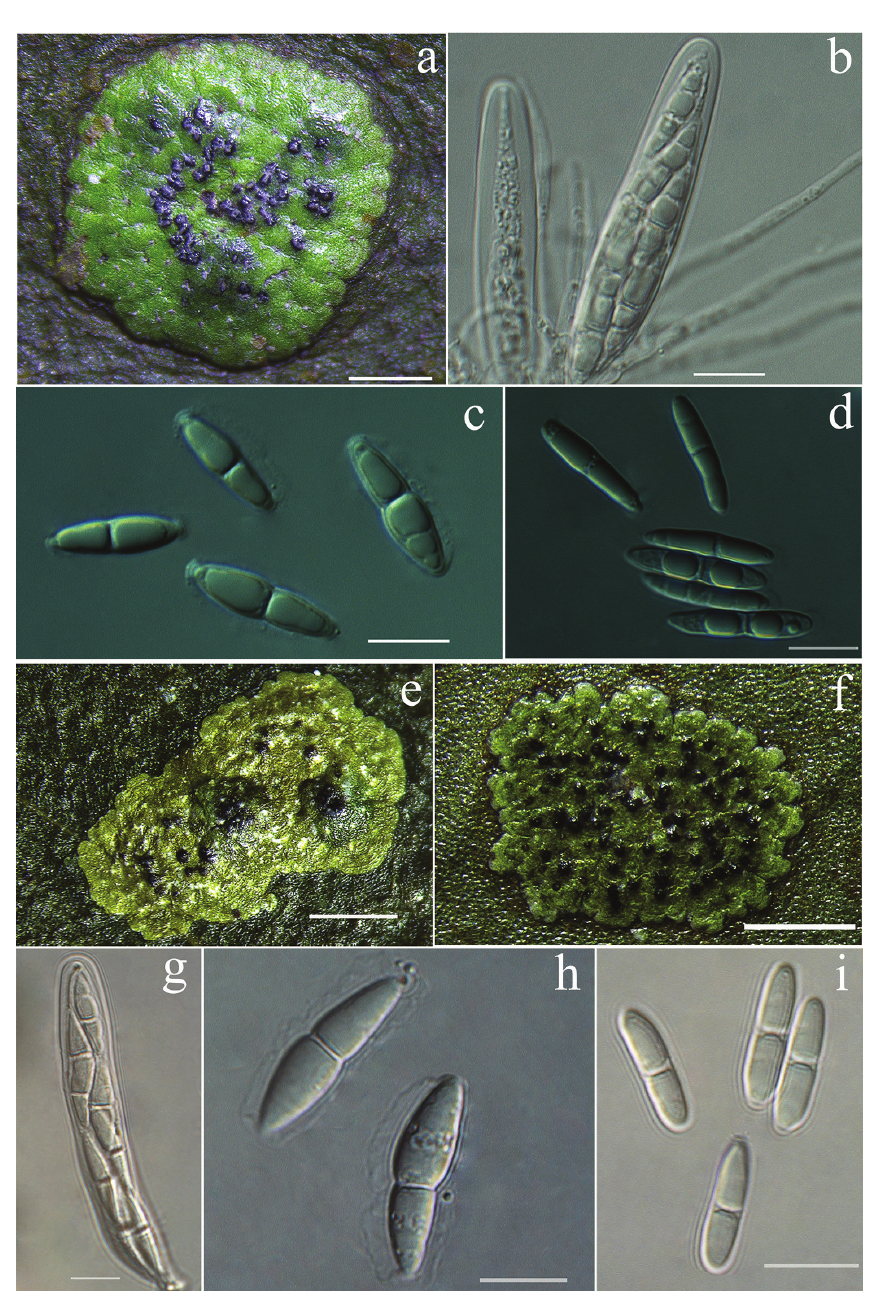
Figure 2. The new species Strigula acuticonidiarum (holotype, HMAS–L 0138045). a Thallus with perithecia and pycnidia b Asci, with eight biseriate ascospores c Ascospores, with constriction at septum d Macroconidia. Strigula smaragdula e Thallus with perithecia (HMAS–L 06211) f Thallus with pycnidia (HMAS–L 0138067) g Ascus, with eight biseriate ascospores (HMAS–L 0138066) h Ascospores, with 1-septate (HMAS–L 0138066) i Macroconidia (HMAS–L 0138066). Scale bars: a, e, f = 300 µm; b, d, h = 10